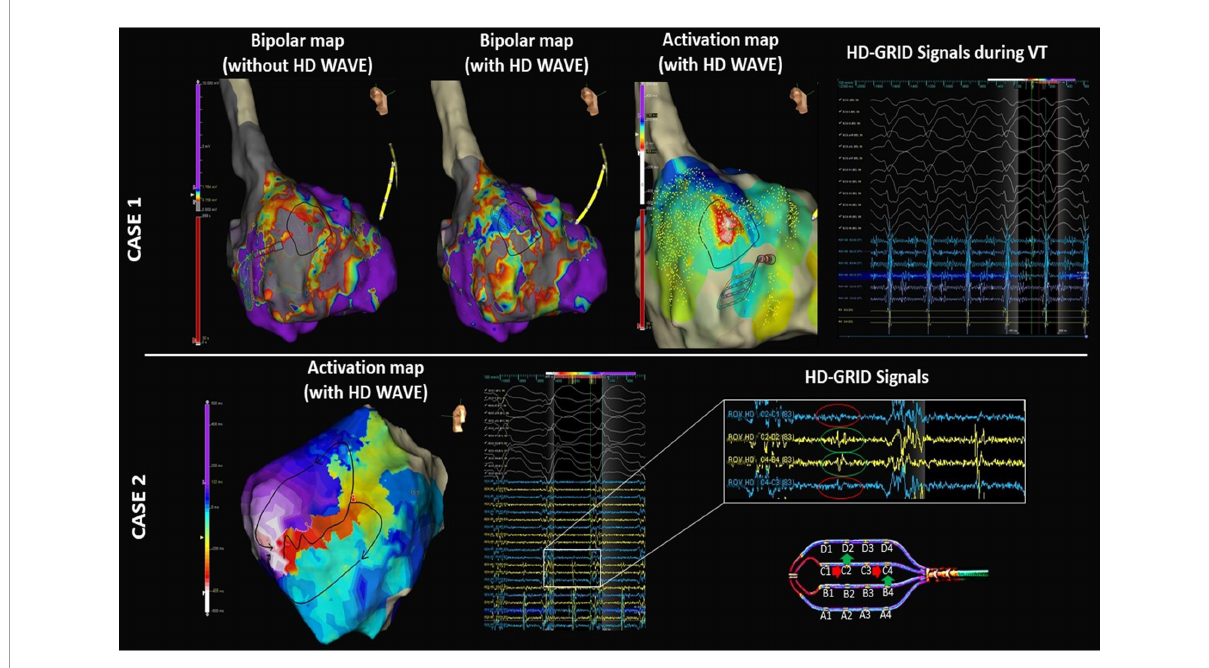
FIGURE4 Electroanatomical maps (EAMs) of the left ventricle in 2 representative examples. Case 1: Left panel: high-density voltage map using only bipolar signals showing an extensive septal scar. Middle panel: the same map obtained using both the bipolar and orthogonal signals (HD Wave algorithm) shows “hidden” viable tissue in the upper part of this septal scar. Right panel: activation map obtained with the HD Grid Mapping Catheter and HD Wave algorithm shows mid-diastolic signals during VT. These mid-diastolic signals were located in the viable tissue only identified by the orthogonal signals during substrate mapping. Case 2: Activation map of VT obtained with the HD Grid Mapping Catheter and HD Wave algorithm. The importance of the orthogonal signals in relation to the activation wavefront is clearly illustrated: The conventional bipolar C1-C2 and C3-C4 (blue tracings) do not show any notable mid-diastolic potentials (red circles). In contrast, orthogonal signals in the same place (C2-D2 and B4-C4, yellow tracing) show clear mid-diastolic EGMs in the isthmus of VT (green circles). The VT activation map is shown in the left